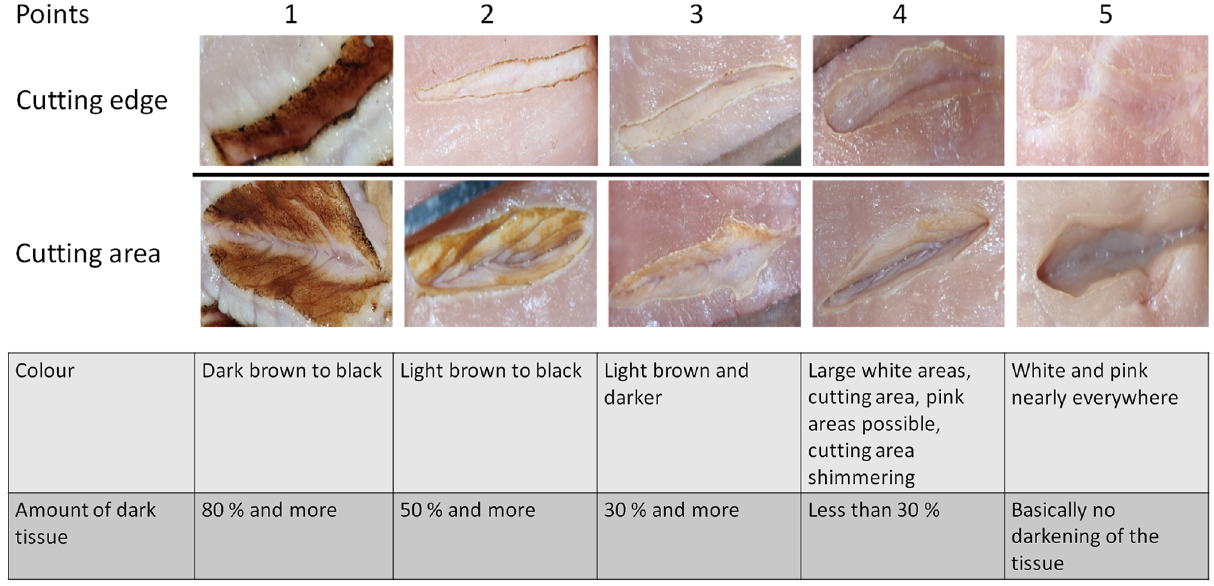
Figure 2. Example of the scoring system: the columns represent the points in the scoring system while the rows represent the scoring for the cutting edge (CE) and the area inside the cut (cutting area),